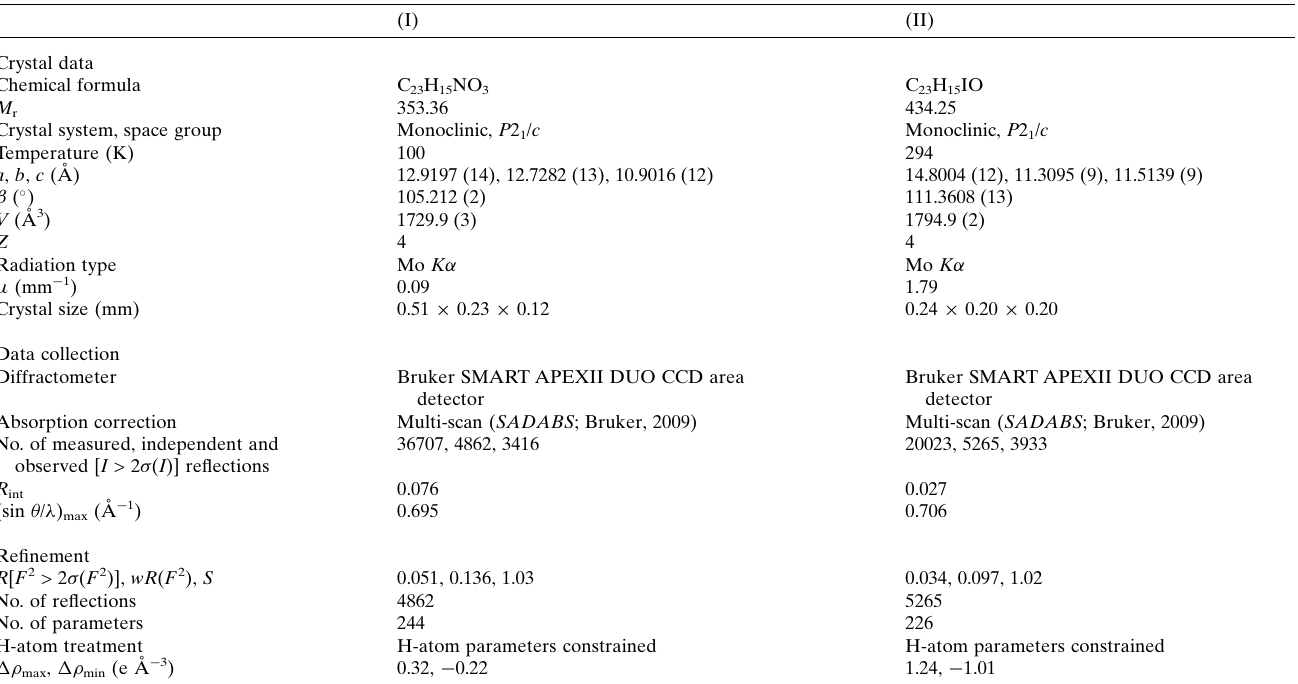
Table 3 Experimental details.